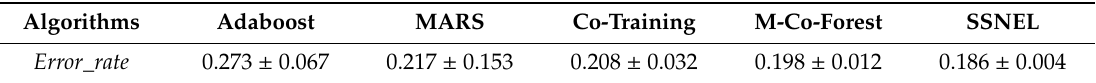
Table 3. The results of the tests on the aluminum electrolytic cell condition dataset.